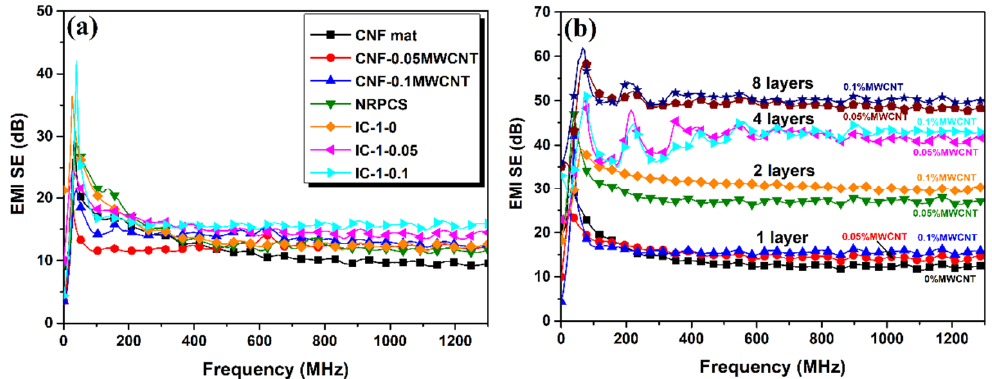
Figure 6. ( a ) Total experimental EMI shielding effectiveness (EMI SE) of nonwoven CNF mat, NRPCS, MWCNT filled carbon nanofiber mats with different MWCNT contents, and one-layered flexible composites; and ( b ) EMI SE of interlayered composites formed by different number of layers of MWCNT filled carbon nanofiber mats with variable MWCNT concentration.